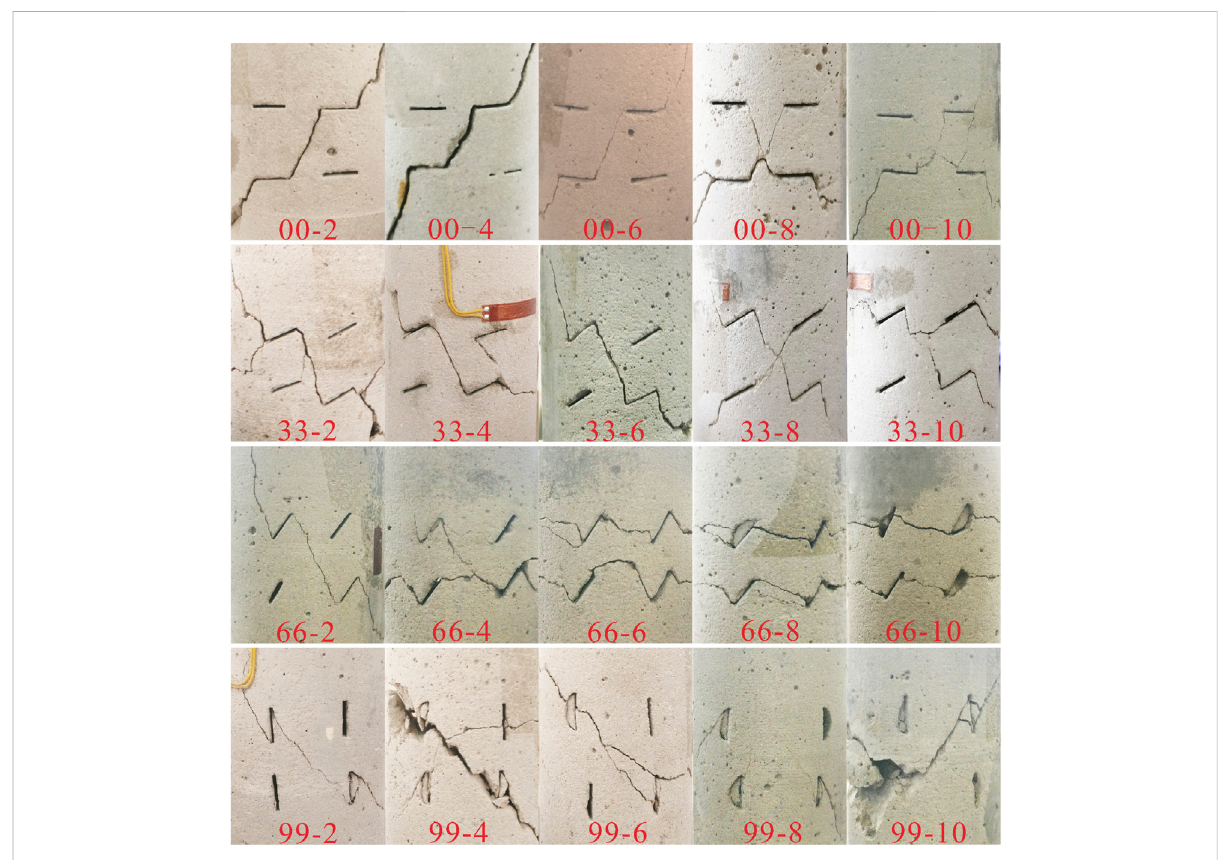
FIGURE 2 The ultimate failure of samples containing four opening fl aws under triaxial compression. *The symbol “ 00-2 ” means that the sample with the inclination angle of 0 ° is loaded at the con fi ning pressure of 2